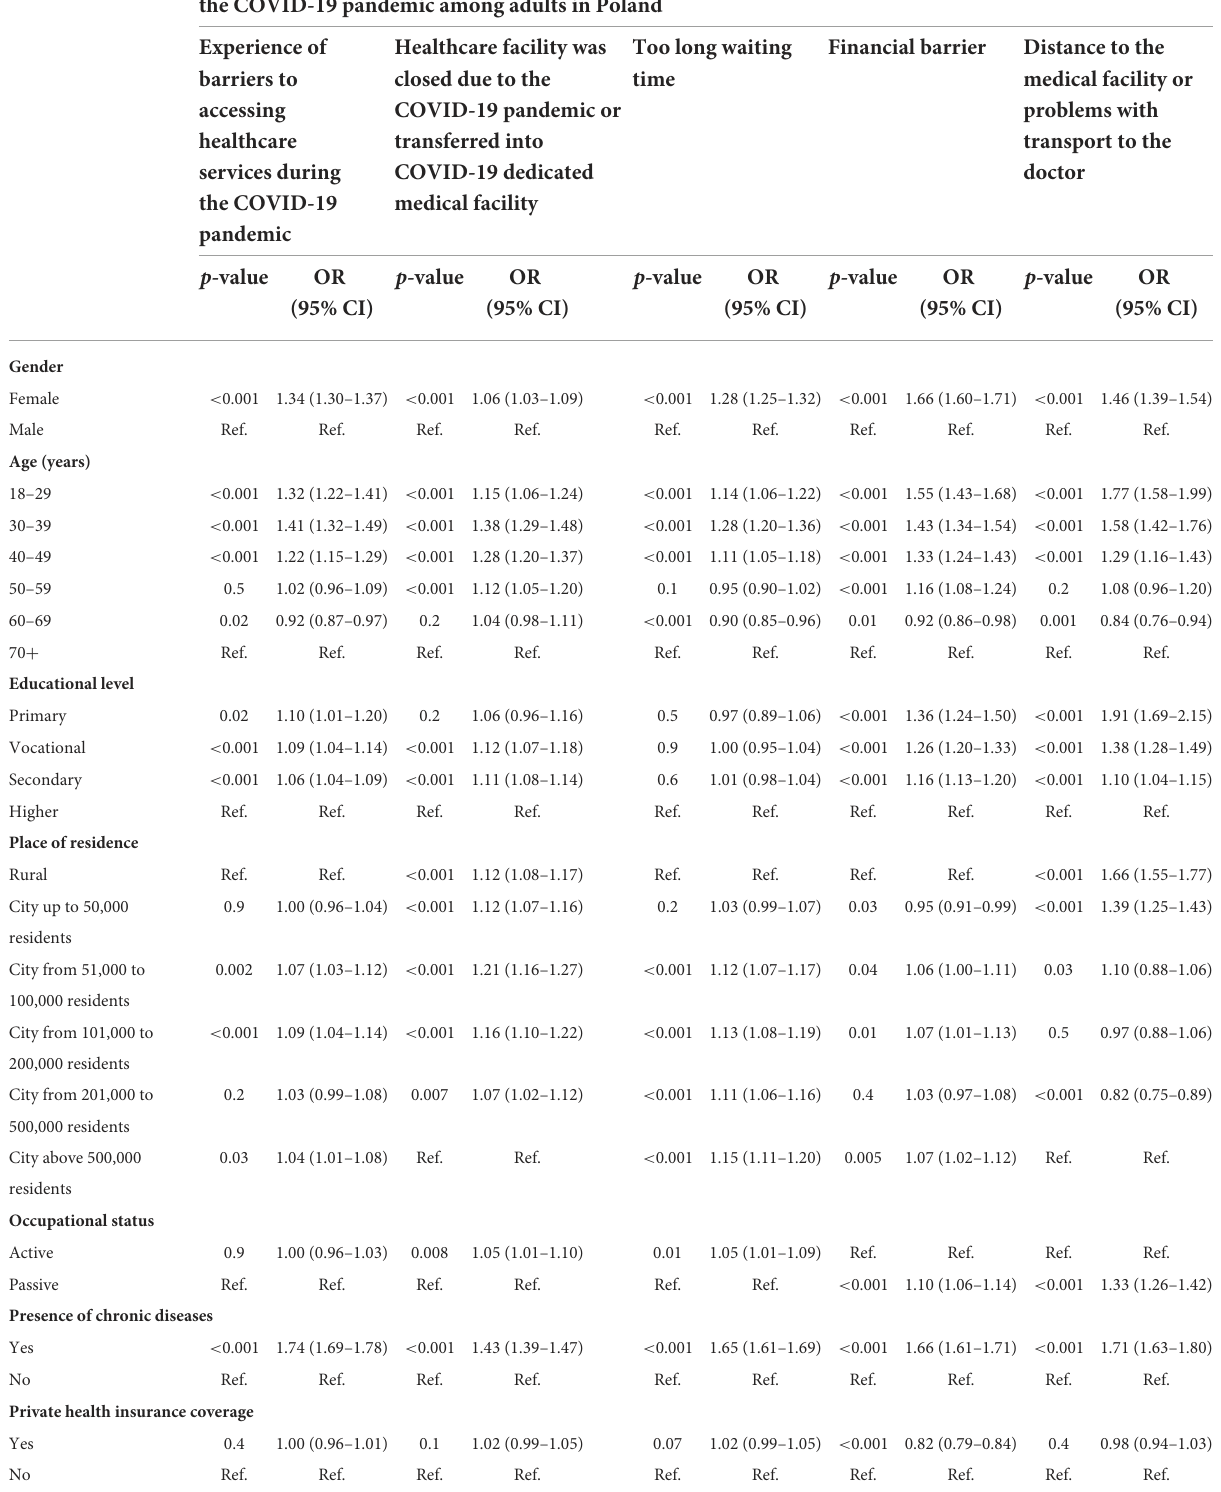
TABLE 4 Factors associated with the experience of barriers to accessing health services during the COVID-19 pandemic among adults in Poland ( n = 102,928) - multivariable logistic regression model.